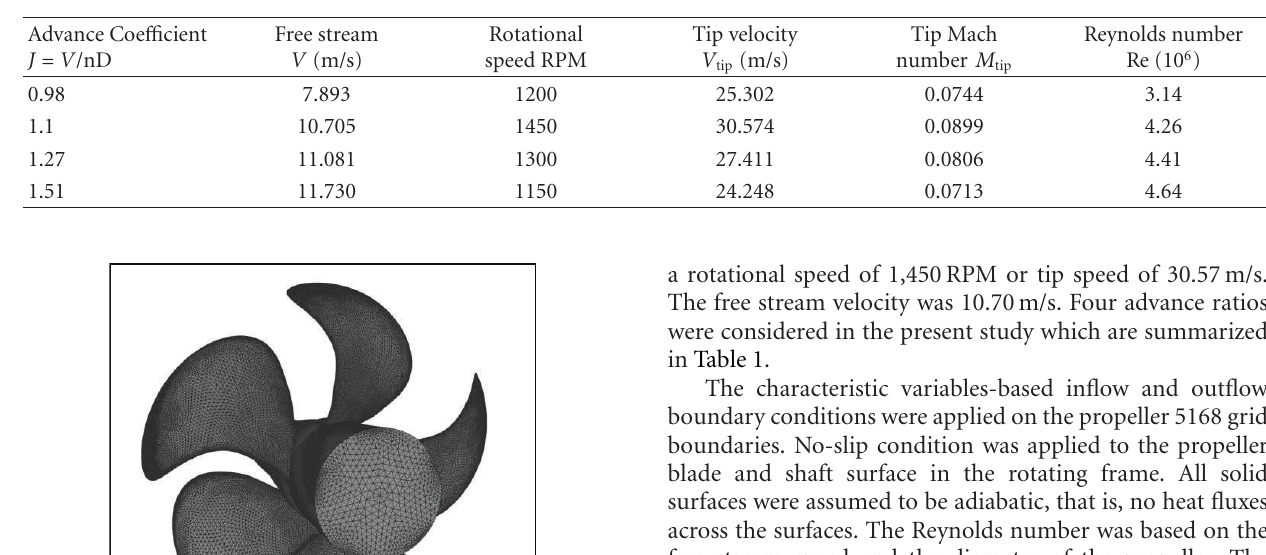
Table 1: Flow conditions of marine propeller p516.